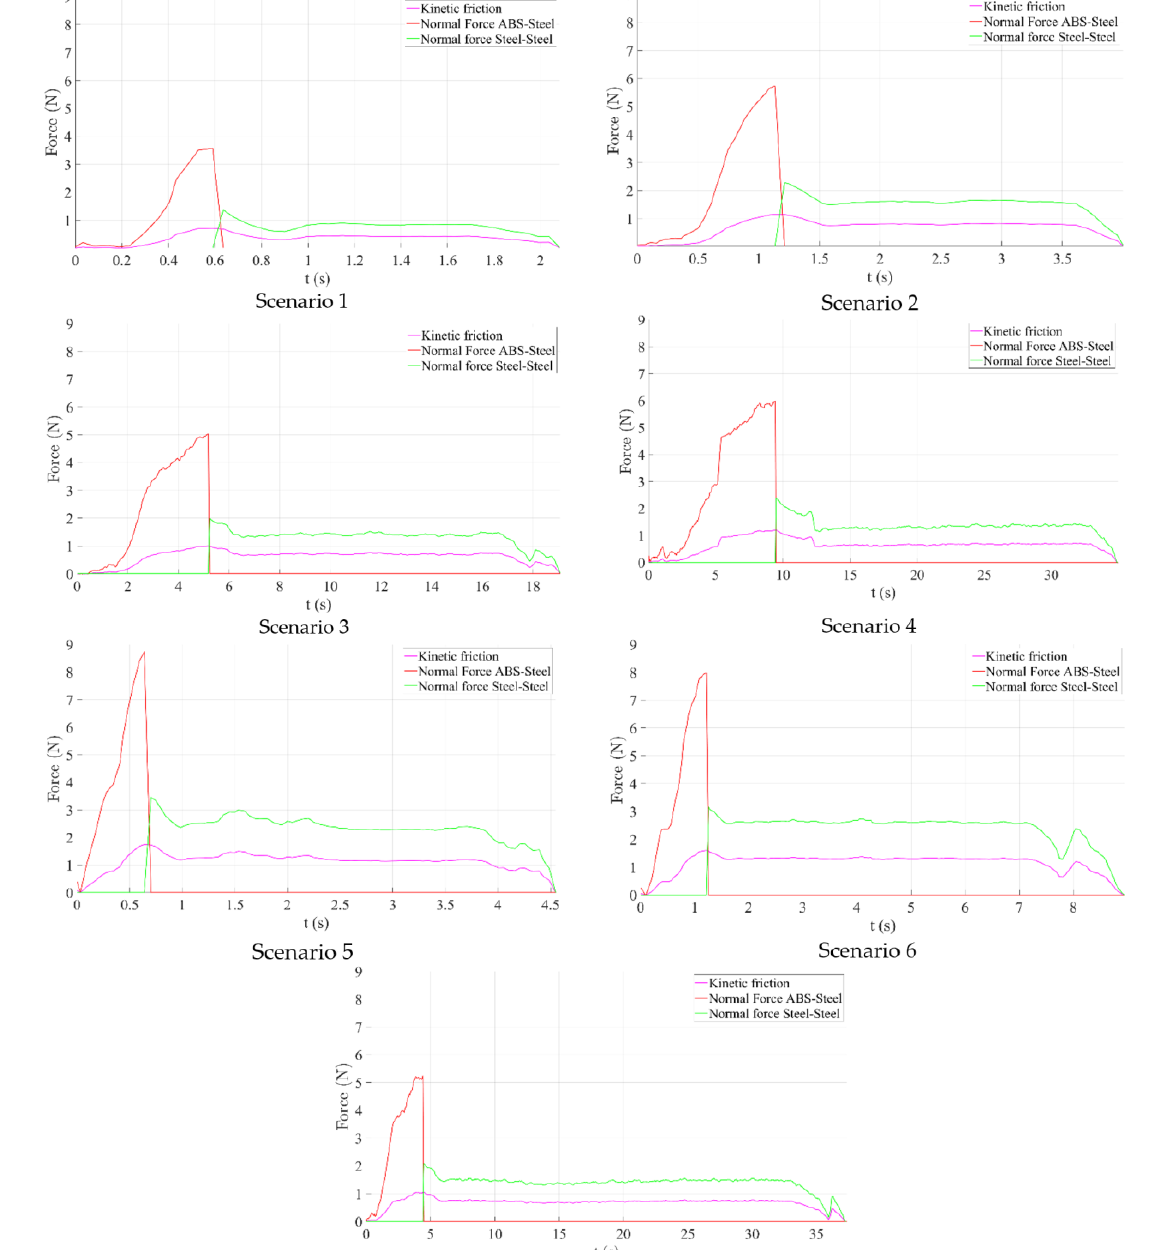
Figure 12. Normal force computation. Table 4. Normal forces acting on the needle maximum values.